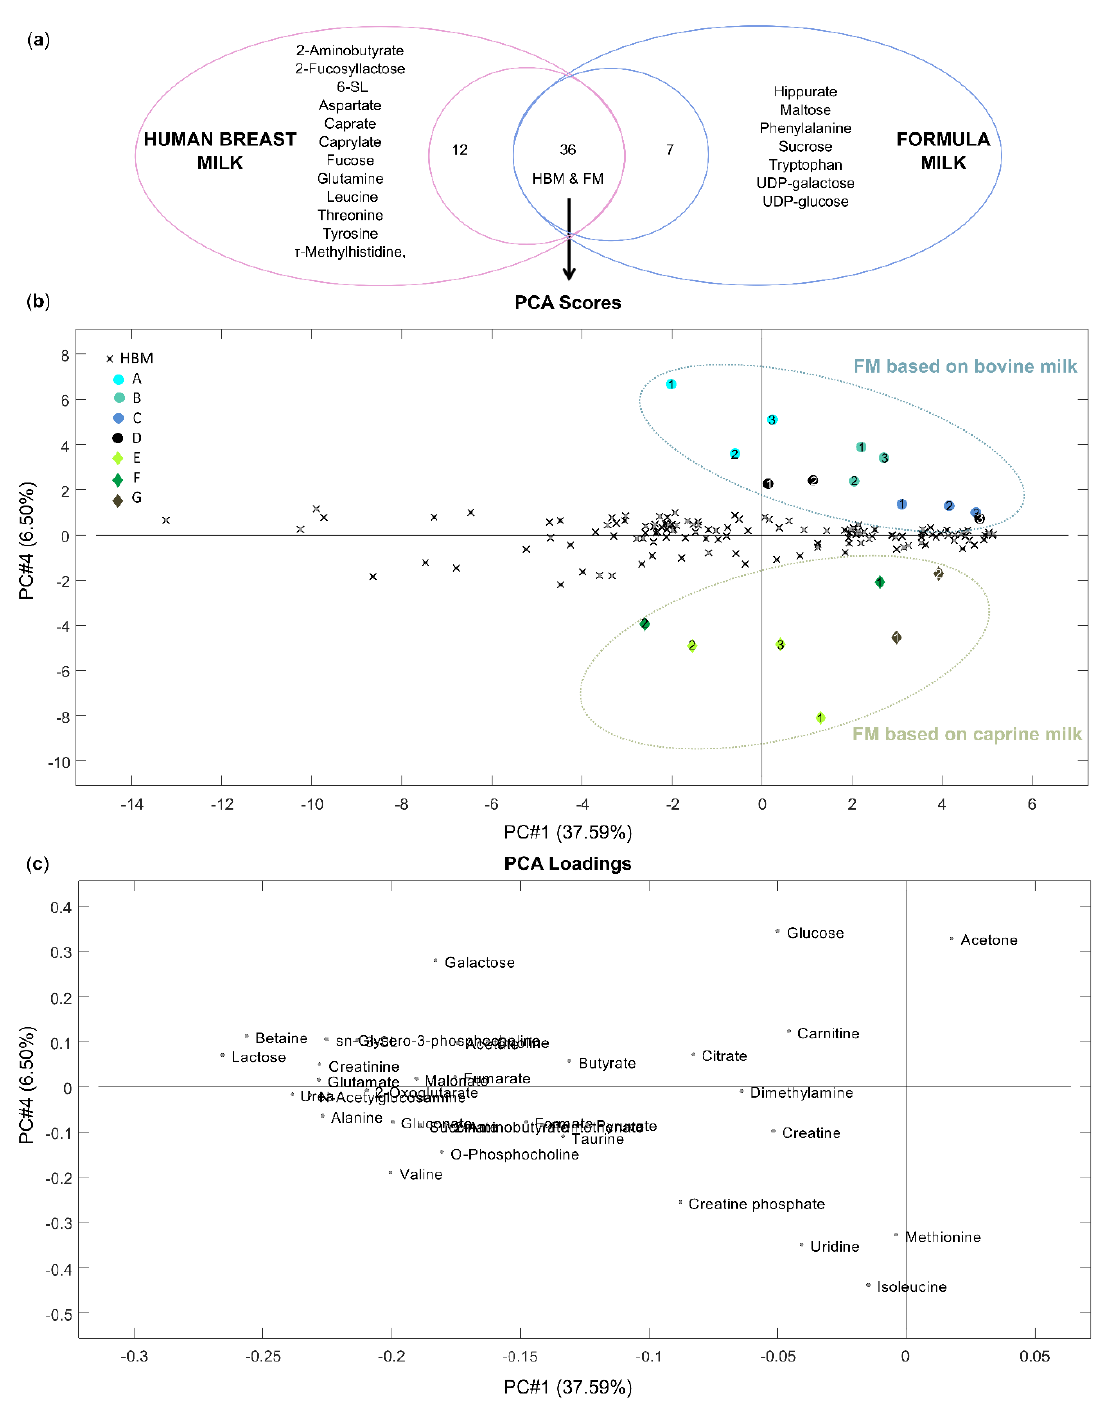
Figure 5. (a) Qualitative differences between polar metabolite composition of HBM and FM Figure 5. ( a ) Qualitative di ff erences between polar metabolite composition of HBM and FM visualized visualized by a Venn diagram; PCA of HBM and FM samples. (b) Score plot, samples colored for by a Venn diagram; PCA of HBM and FM samples. ( b ) Score plot, samples colored for HBM and brands HB M and brands of FM (see Table S2); and (c) loading plot. of FM (see Table S2); and ( c ) loading